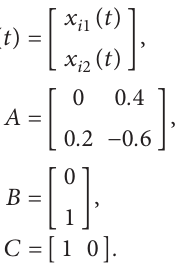
Figure 2: The control inputs for tracking